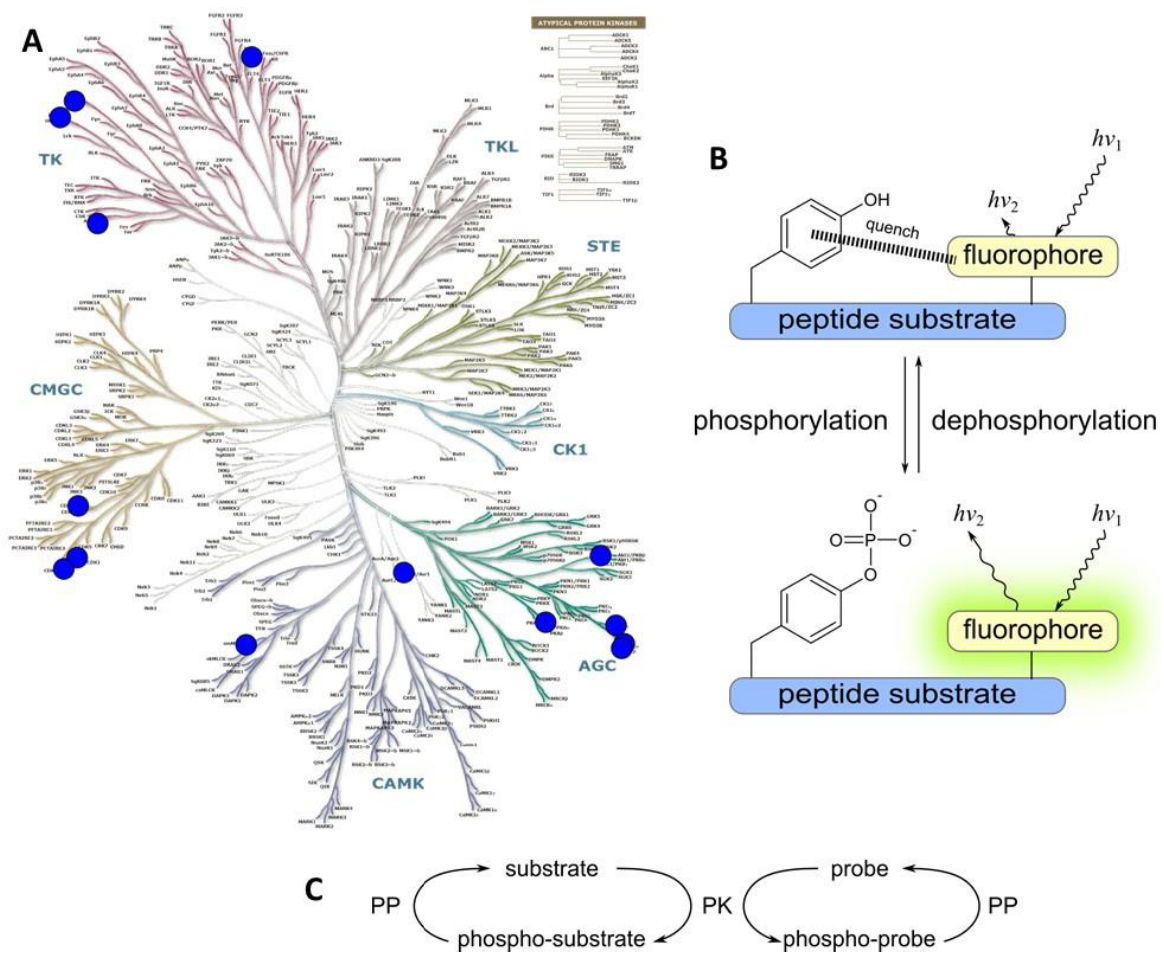
Figure 4. Class 1B probes. ( A ) Human PKs for which Class 1B probes (blue circles) have been reported (kinome tree adapted from [104], illustration generated by analog of software available at [105]). ( B ) Principle of functioning of a self-quenching probe (adapted from [96]). ( C ) Probe competes with the endogenous substrate for phosphorylation.